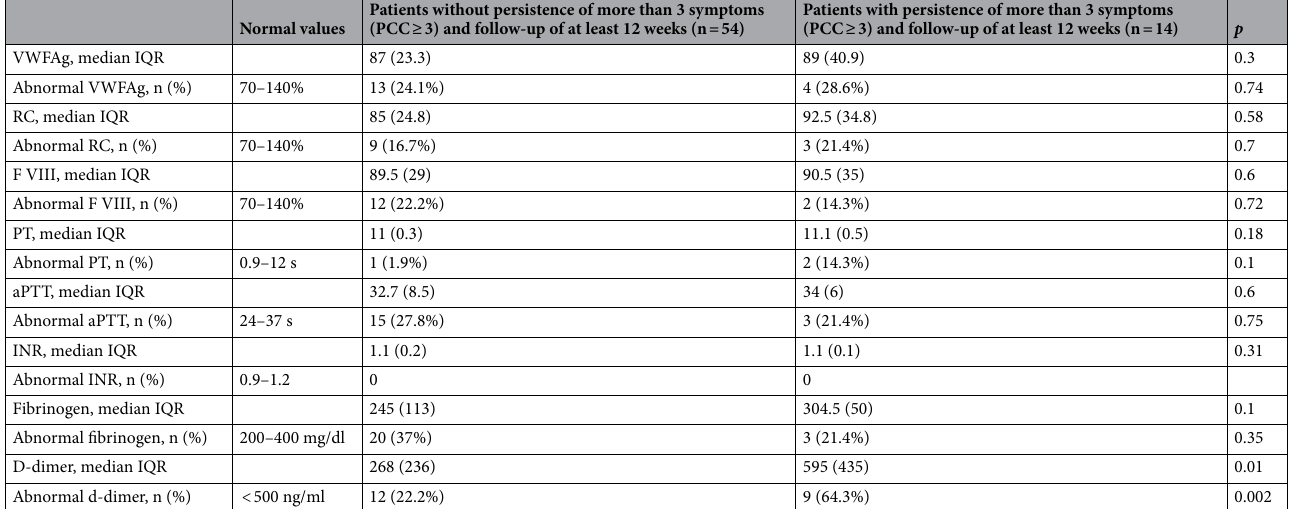
Patients with persistence of more than 3 symptoms (PCC ≥ 3) and follow-up of at least 12 weeks (n = 14)